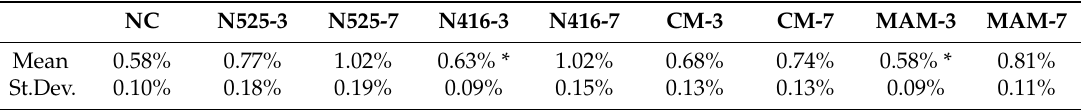
Table 2. Elongation at break with standard deviations. Insignificant changes compared to NC at 95% confidence level are marked with an asterisk (*).